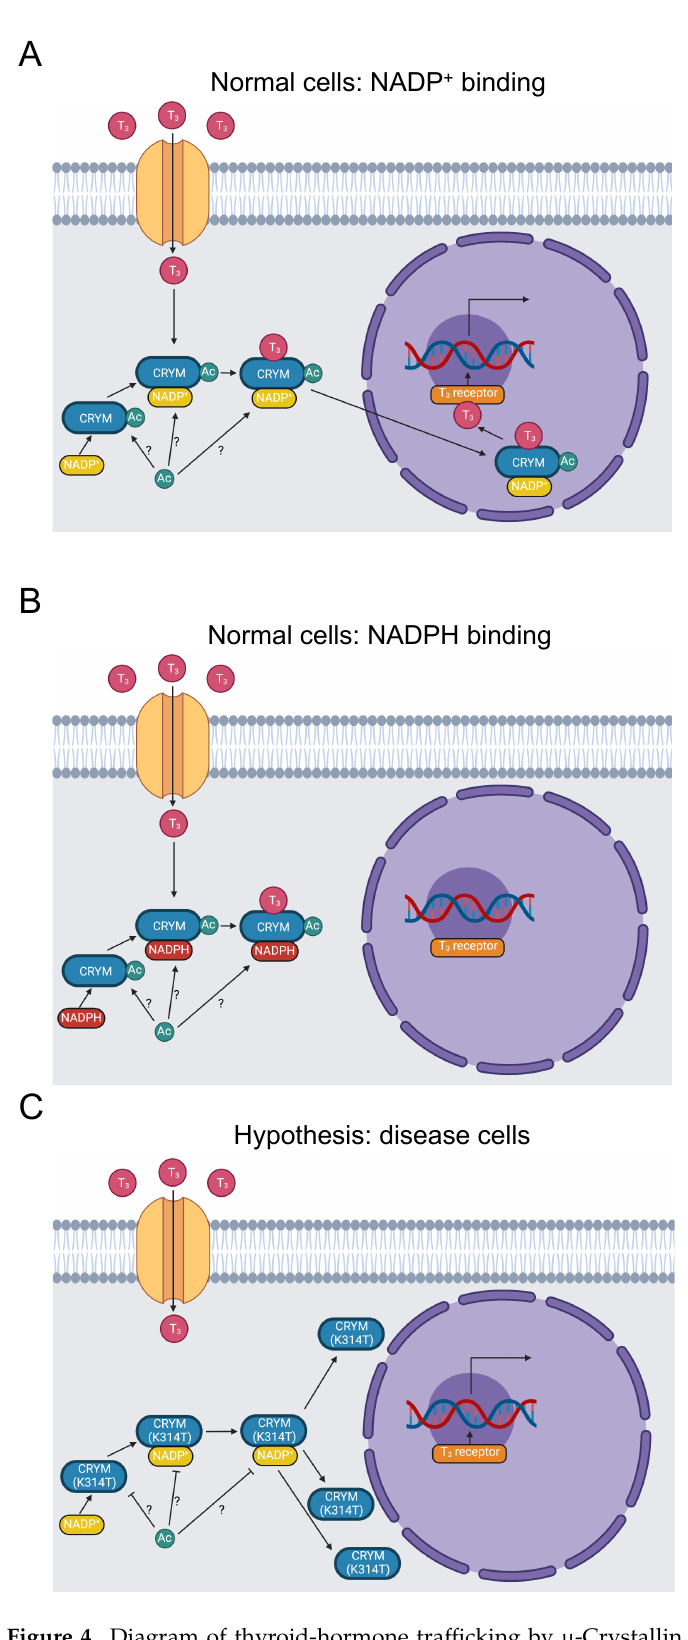
Figure 4. Diagram of thyroid-hormone trafficking by µ -Crystallin and subsequent transcription promoted by a thyroid-hormone receptor. ( A ) Thyroid hormone enters the cytoplasm and